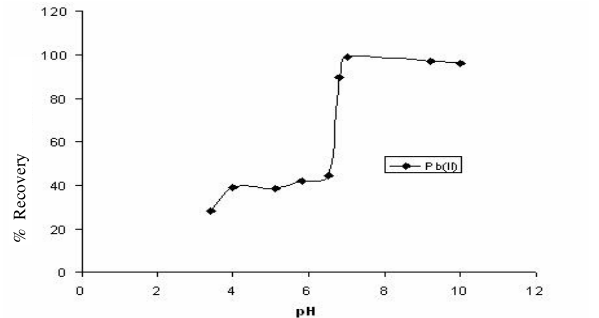
Figure 2. Effect of pH on analyte recovery.